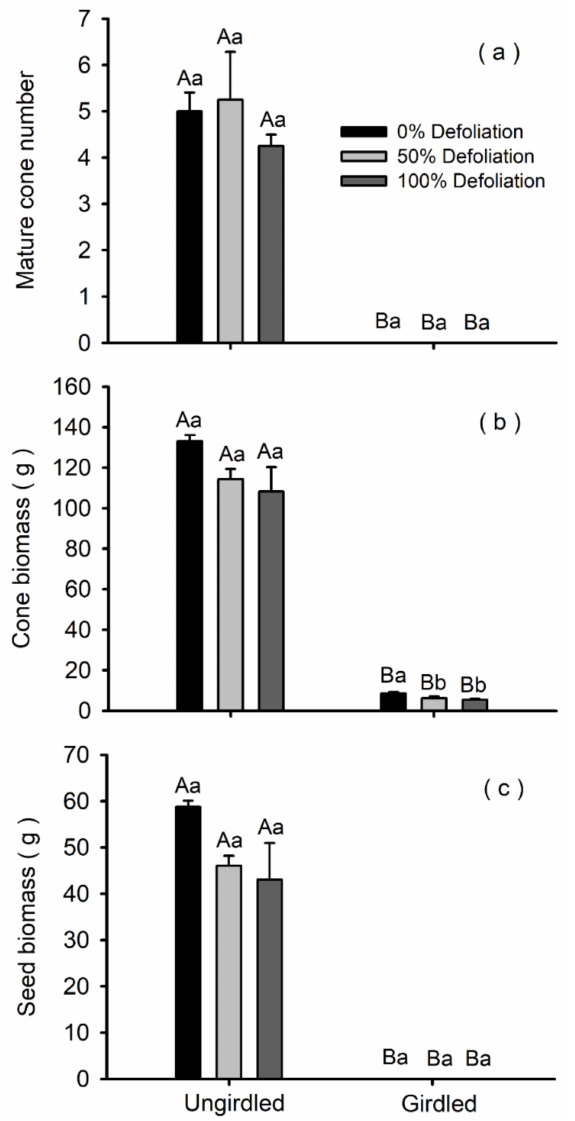
Figure 3. Number of mature cones ( a ) and cone and seed biomass ( b – c ) in response to girdling and defoliation treatments in Pinus koraiensis . The number of mature cones and the seed biomass were nil in girdled branches. Bars and arrows represent the mean and corresponding standard error, respectively, per treatment combination. Different capital letters indicate a significant effect of girdling for a given defoliation intensity ( p < 0.05). Different lowercase letters indicate significant differences among defoliation intensities for a given girdling group ( p < 0.05). Means were compared using LSD